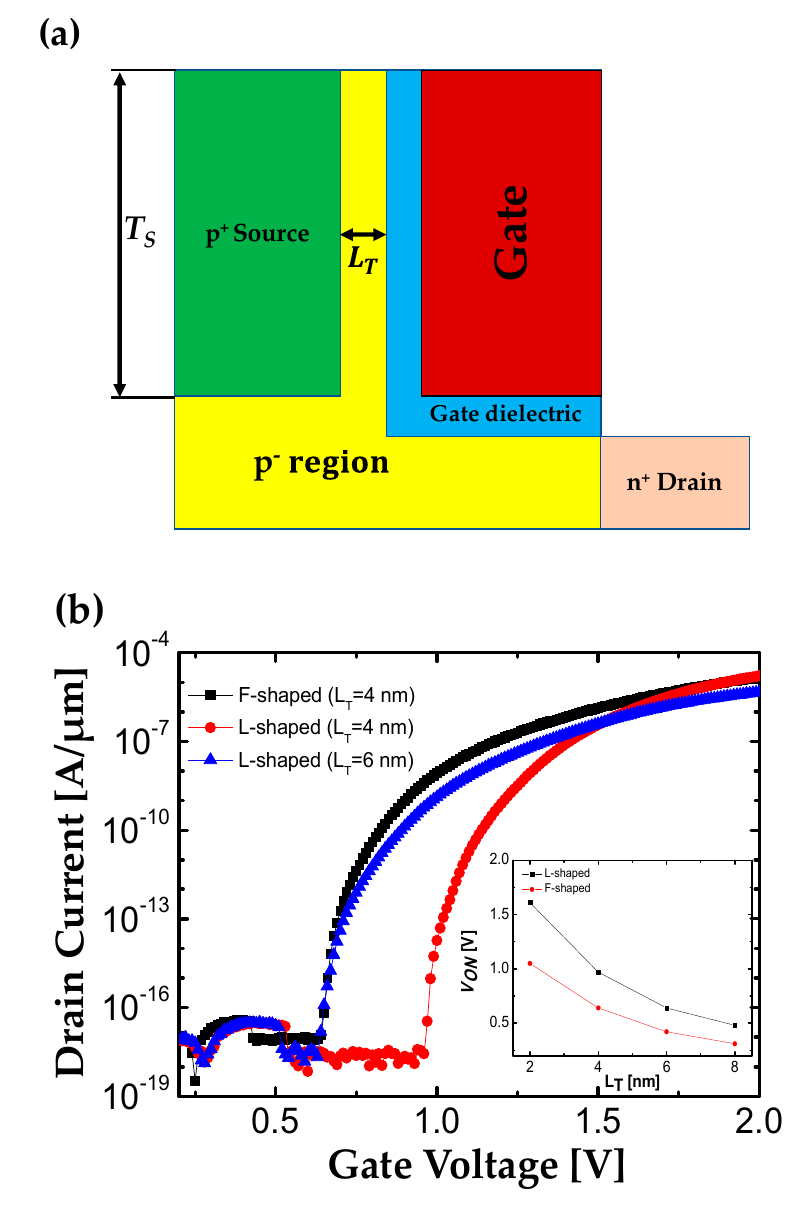
Figure 6. ( a ) Structure of L-shaped TFET. ( b ) Transfer characteristics of L-shaped and F-shaped TFETs at V DS = 0.7 V. The inset figure shows V ON of both TFETs as a function of L T from 2 to 8 nm. In case of 4 nm- L T , L-shaped TFET has the same dimension as the optimized F-shaped TFET discussed in Section 2.1. As shown in Figure 6b, it is clear that the V ON of F-shaped TFET is about 0.4 V lower than that for L-shaped TFET in spite of the same dimension with the help of the electric field crowding e ff ect. The inset of Figure 6b confirms that V ON of F-shaped TFET is always smaller than that for L-shaped TFET with the same L T